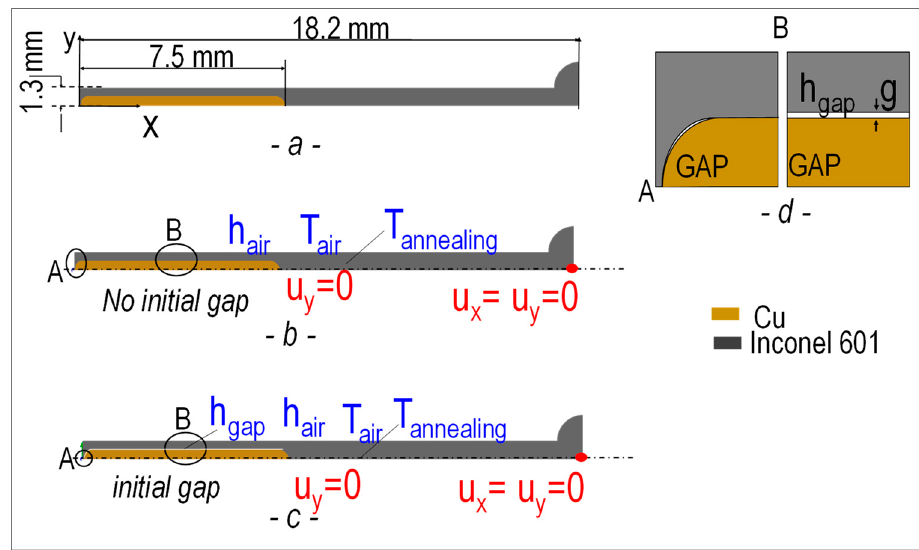
Figure 7. Considered geometries ( a ) overall dimensions, ( b ) geometry without initial gap between the copper and Inconel, ( c ) with an initial gap of 5 µ m, ( d ) zoom on the initial